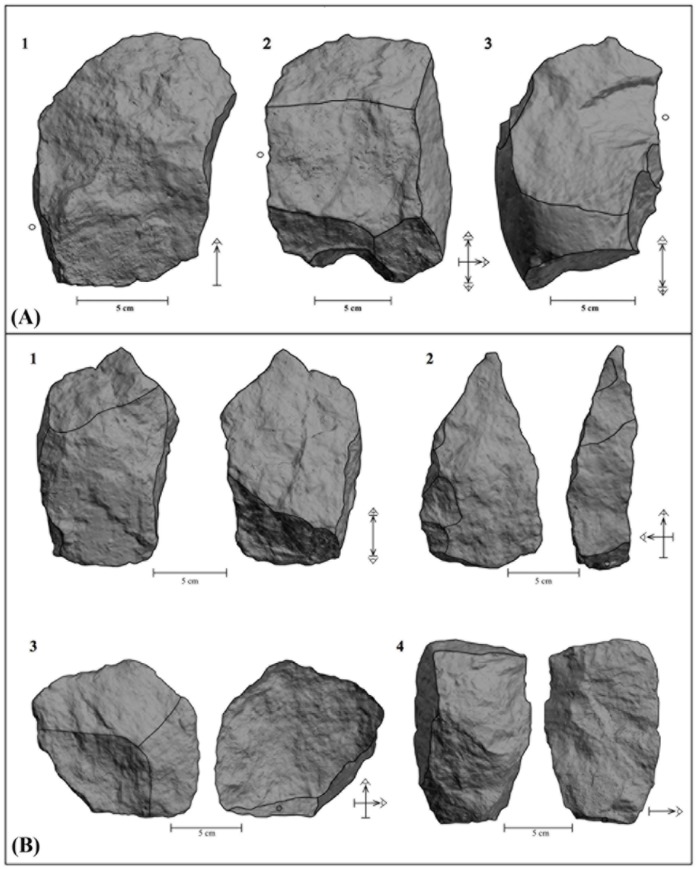
LCTs from FLK W.(A) 3D models of 3 cleavers and their tool functioning schemes (butt is indicated by a dot). (B) 3D models of RI 1 artifacts (1 and 2) and RI 0 artifacts/flakes (3 and 4) and their tool functioning schemes (RI = Reduction intensity) (butt is indicated by a dot).